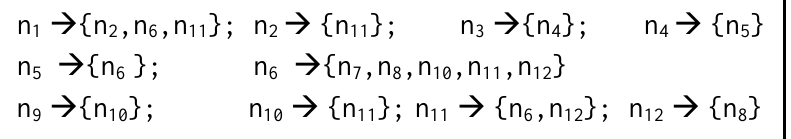
Fig. 5: Adjacency list of each node in the GQG in Fig.